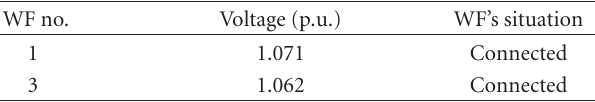
Table 6: Results obtained with proposed controller in the case of 2WFs. WF no. Voltage (p.u.) WF’s situation 1 0.684 Disconnected 3 0.705